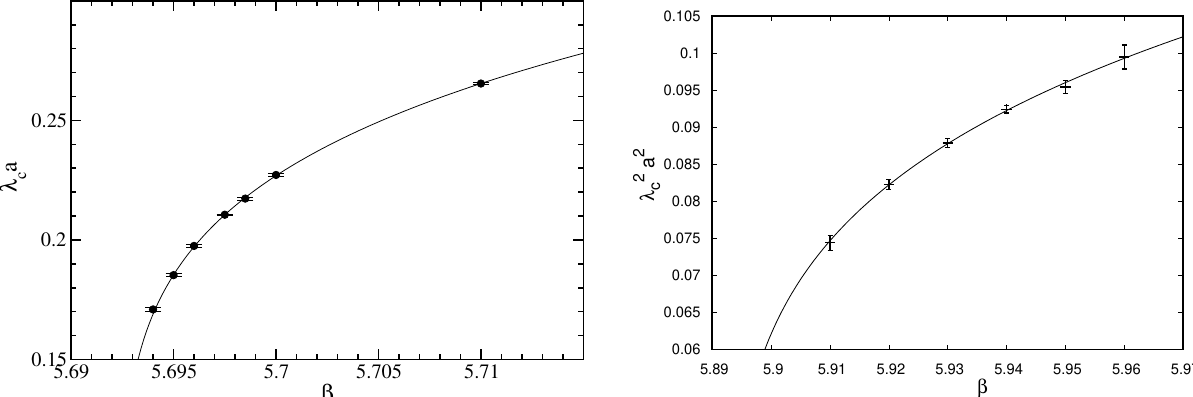
Figure 15. Mobility edge in pure gauge SU(3) theory in the staggered ( left ) and overlap ( right ) Dirac spectrum. From Refs. [51,54]. (Figures adapted from T.G. Kovács and R.Á. Vig, Phys. Rev. D 97, 014502 (2018) (left), and from R.Á. Vig and T.G. Kovács, Phys. Rev. D 101, 094511 (2020) (right), and used under a CC-BY 4.0 license (https://creativecommons.org/